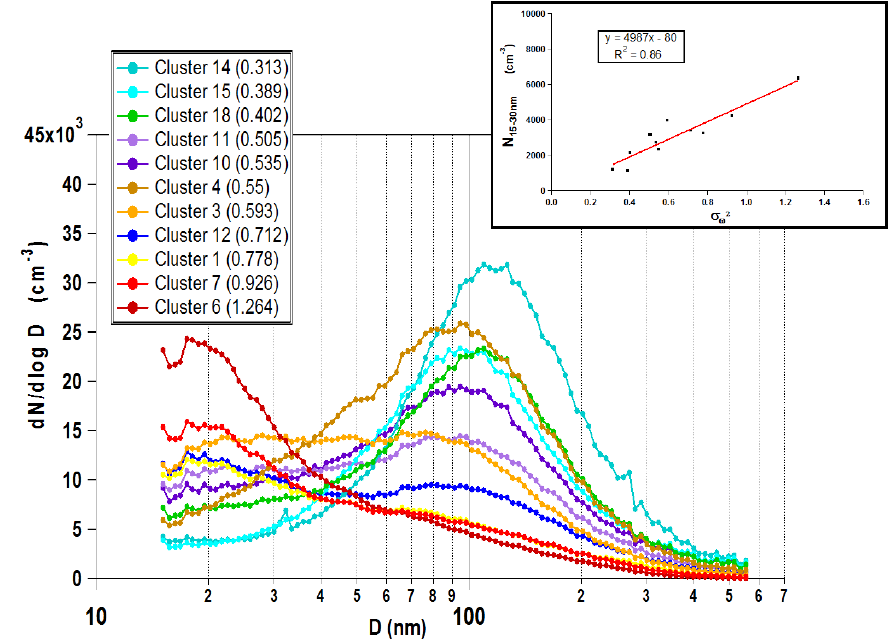
Fig. 8. SMPS clusters analysis found at the BT Tower site. For each of the 11 clusters reported, in the legend an average value of σ 2 w (m 2 s − 2 ) BT Tower obtained with the Lidar is